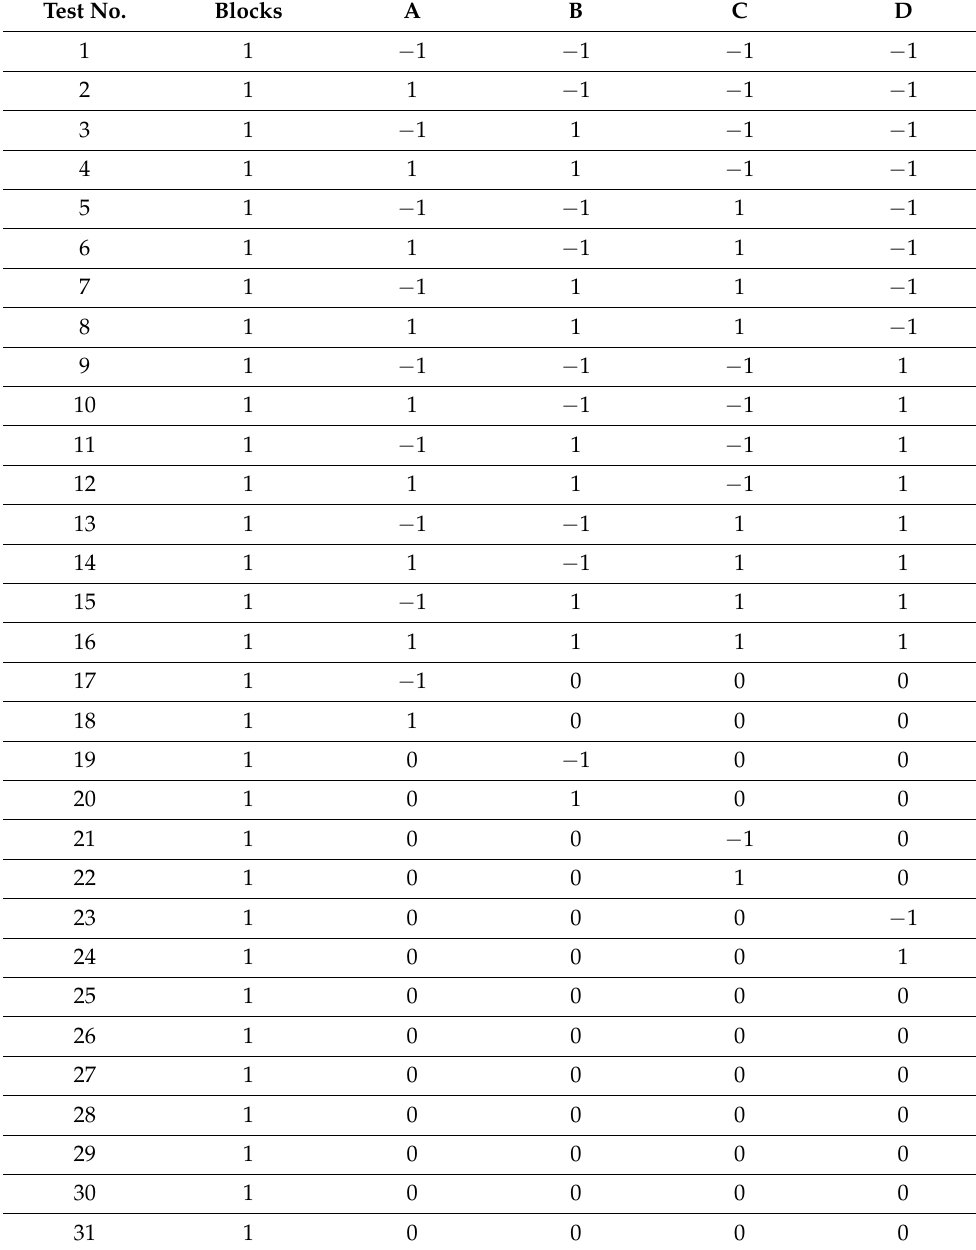
Table 7. L 31 Central Composite